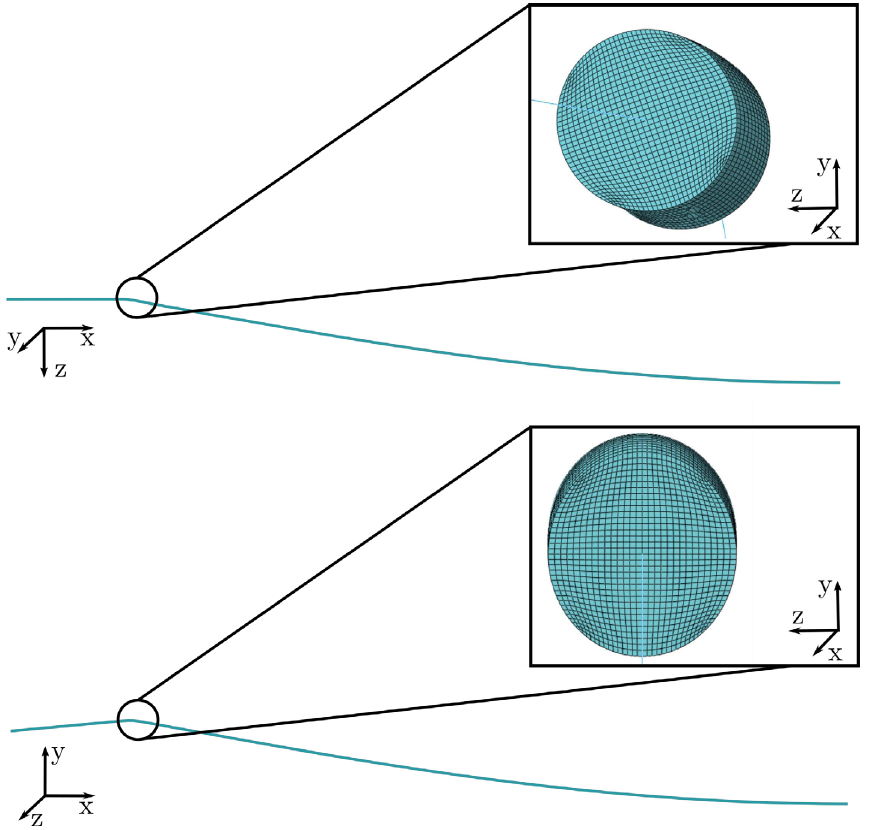
Figure 12. First eigenmodes of the numerical half-string model in horizontal plane (top) and vertical (bottom). The part on the saddle is magni fi ed for both